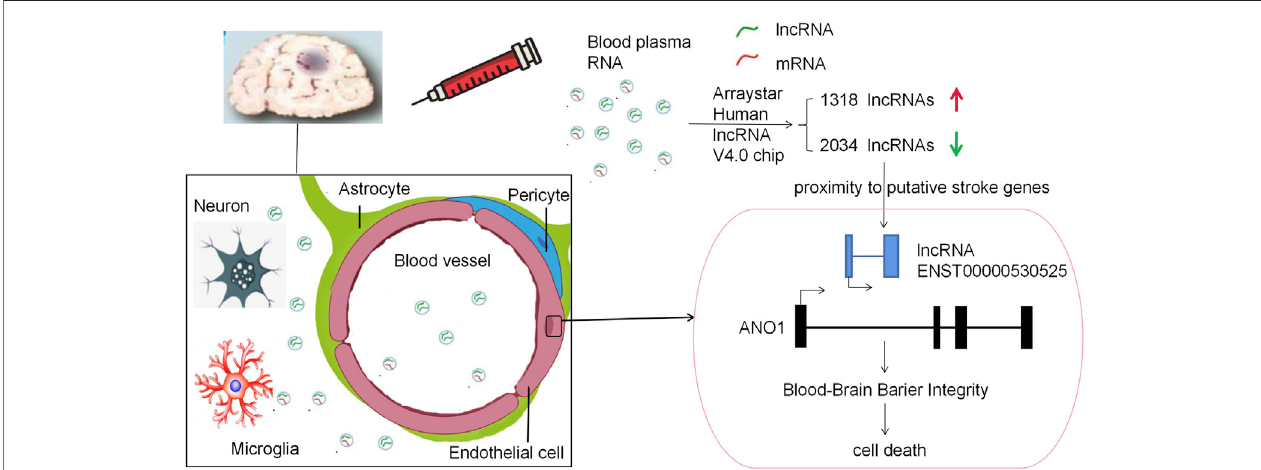
FIGURE9| Schematicdiagramofthispaper.ThisstudyusedaRNA-chipsequencinginwholebloodsamplesofpatientssufferingfromacutecerebralischemiato identify DE lncRNAs. The Arraystar Human lncRNA V4.0 chip results showed there were 3352 lncRNA transcripts DE, with 1318 upregulated and 2034 downregulated lncRNAs. LncRNA ENST00000530525 was the highest downregulated lncRNA, while ANO1 was in proximity to the putative stroke gene. Upregulating lncRNA ENST00000530525 improved the expression of ANO1, which further destroyed the BBB integrity, in the hCMEC/D3 cells after